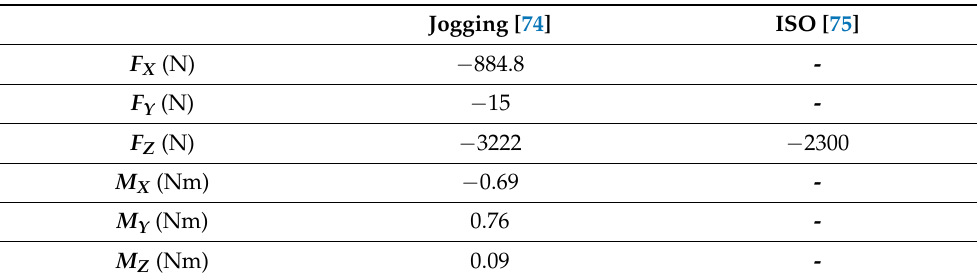
Table 3. Standardized loads for the intact and implanted